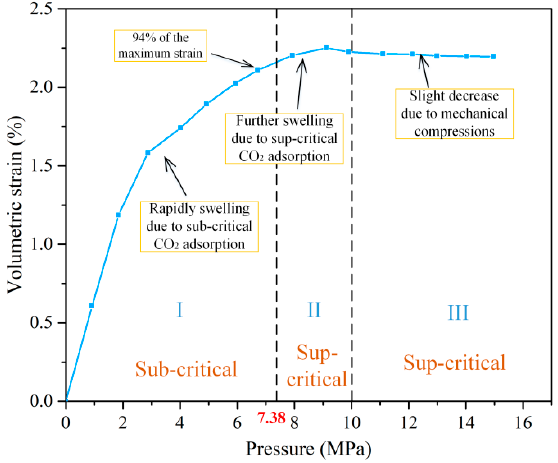
Figure 9. The absolute adsorption isotherm and the excess adsorption isotherm of CO 2 at 50 °C.